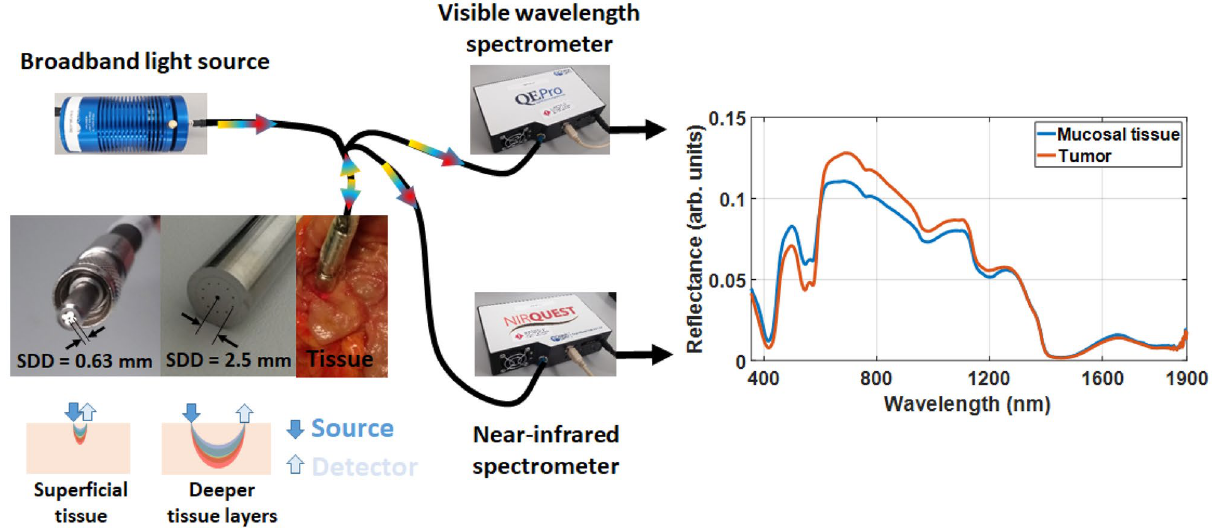
Figure 2. Schematic image of the DRS system. The reflected light can be collected in a wide range of wavelengths and thus, allow the investigation of a larger variety of chromophores in biological